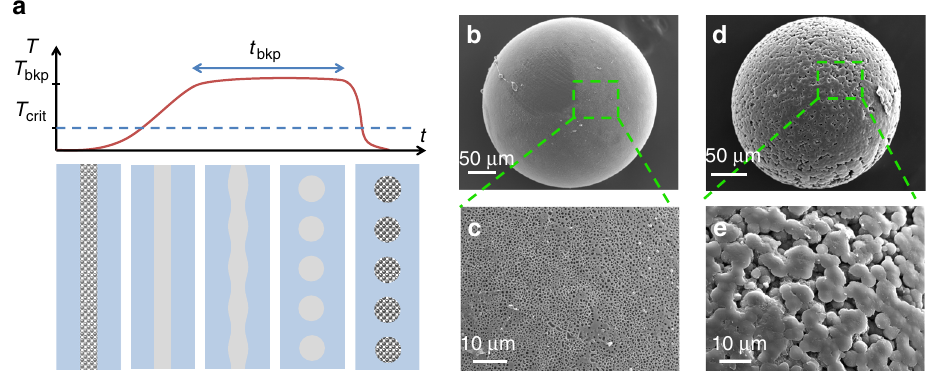
Fig. 5 Porous microsphere production with controlled capillary breakup of porous core fi bers. ( a ) General illustration of the capillary breakup process. Fibers are reheated above the phase transition temperatures of the solution and glass transition of the cladding. The core then evolves into a row of spheres under the effect of surface tension. Once breakup is completed samples are rapidly quenched. ( b , c ) SEM image and close-up of a polycaprolactone (PCL) porous microsphere and of ( d , e ) a polyvinylidene fl uoride porous